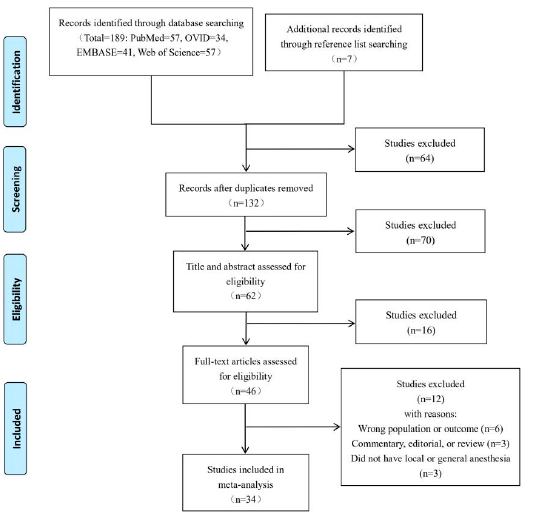
Figure 1. Flow diagram of study selection process corresponding to PRISMA statement.